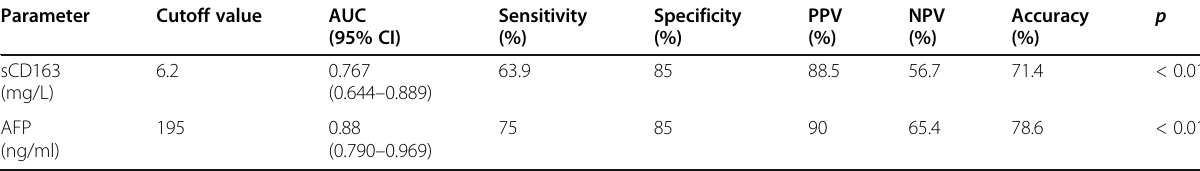
Table 3 Diagnostic performance of the best cutoff values of sCD163 and AFP in discriminating HCC groups from LC group Parameter Cutoff